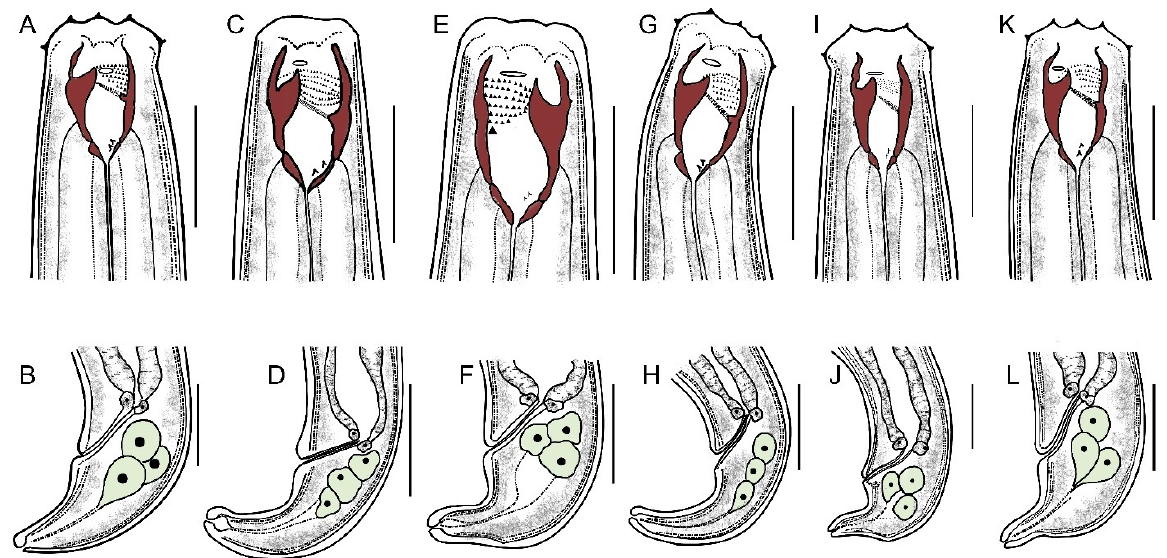
Figure 3. Line illustrations of six Mylonchulus species. ( A , B ) Mylonchulus brachyuris (Bütschli, 1873)